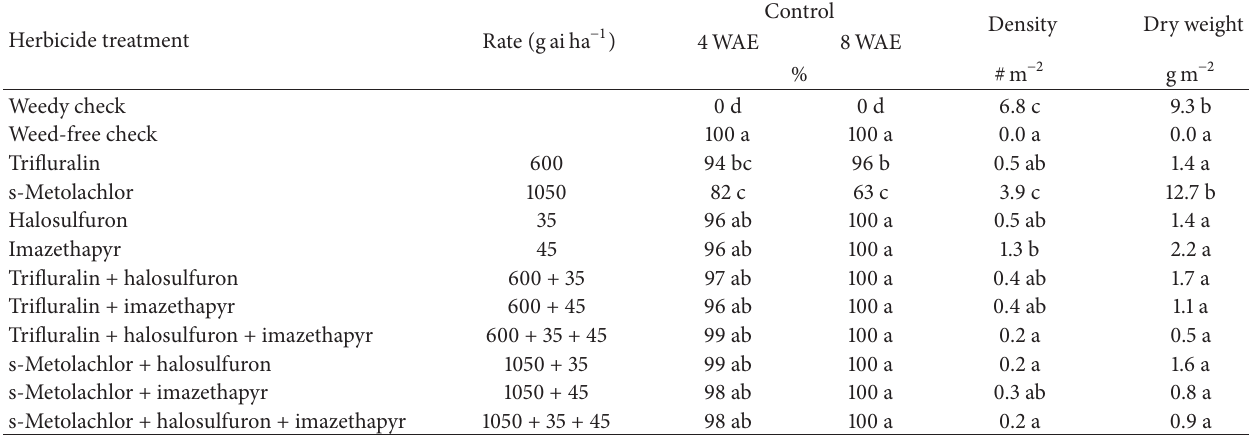
Table 4: Percent control, density, and dry weight of common lambsquarters in white bean treated with halosulfuron tankmixes applied PPI at Exeter (2011–2013) and Harrow, ON (2012). Means followed by the same letter within a column are not significantly different according to Fisher’s Protected LSD at 𝑃 < 0.05 a